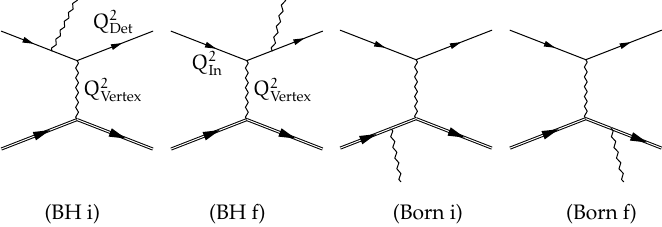
Figure 3. Feynman diagrams for inelastic scattering of electron o ff a proton, where the electron and proton emit real photons before or after the interaction. Diagrams where electrons emit a photon are known as Bethe-Heitler (BH) diagrams, while those where protons emit real photons are called Born diagrams. The Q 2 represents Vertex the square of the four-momentum transferred to the hadron. The Q 2 is the momentum fixed by the beam energy In ≤ Q 2 and the scattering angle, while the Q 2 corresponds to value measured with the detector. For the (BH-i) Det In = Q 2 = Q 2 Q 2 , and for the (BH-f) Q 2 Vertex Det Vertex In